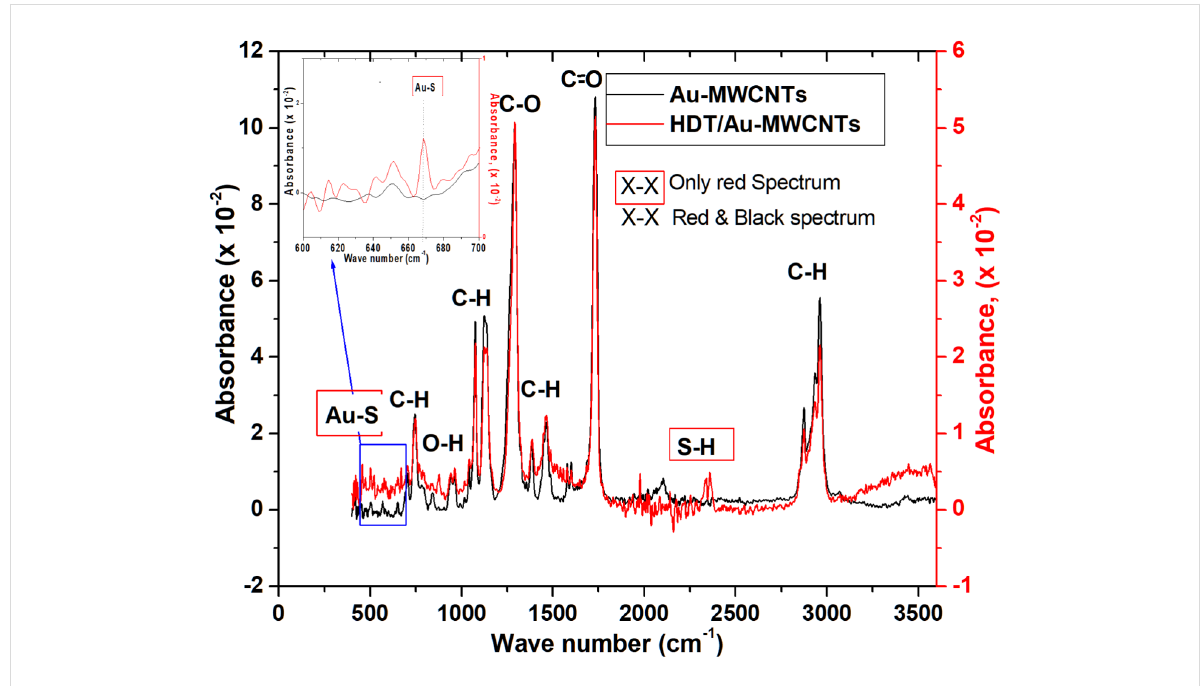
Figure 3: Infrared spectra of Au-MWCNT and SAM/Au-MWCNT